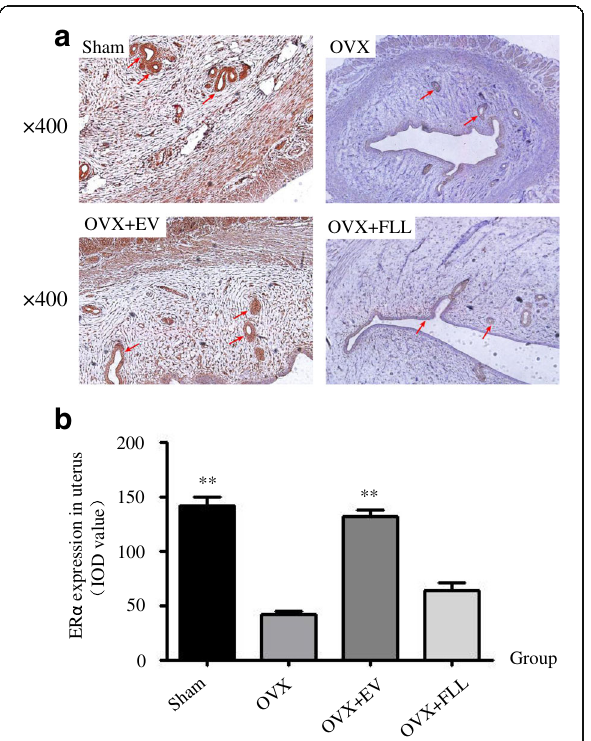
Fig. 4 The representative images ( a ) and images analysis results of immunohistochemical staining ( b ) showing the effect of FLL on ER α expression in the uteri of the rats. The arrows illustrated the expression and distribution of ER α . Data are presented as mean±SD. ** P <0.01 compared with the OVX control